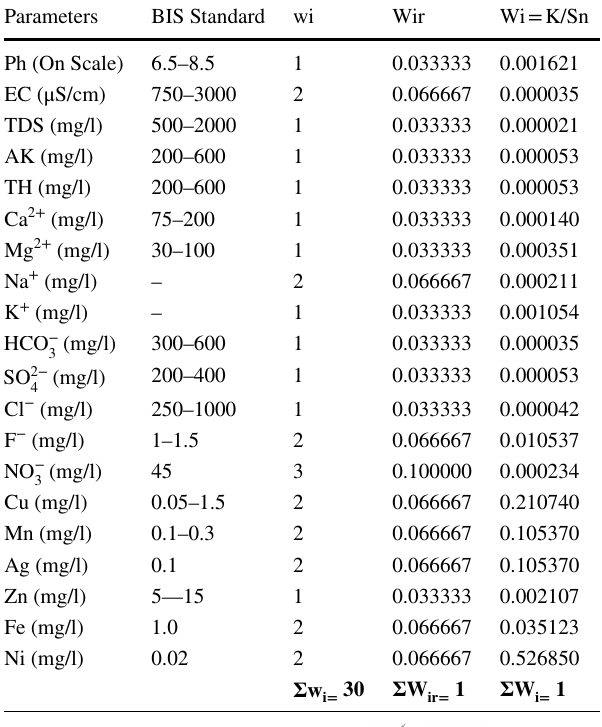
i ), relative weightage (W ir ) and unit weightage